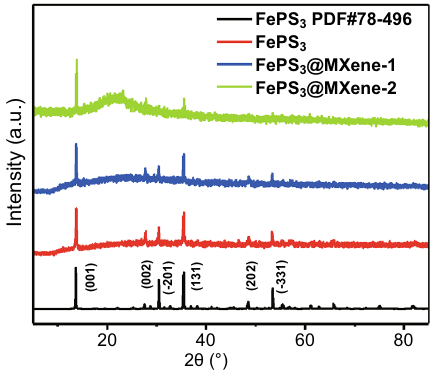
Fig. 3 Powder XRD patterns of the synthetic FePS 3 , FePS 3 @ MXene-1, and